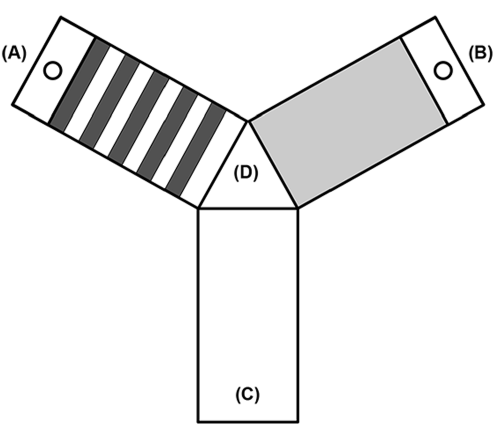
Figure 1. Y-mazes used to assess learning ability in L.delicata and L.guichenoti . Each maze had three arms of equal length. Two maze arms were painted with contrasting colours (orange and blue) and patterns (stripes and solids) to provide visual cues. All colour- pattern combinations were replicated and reversed in our study (four mazes total). Two arms contained feeding wells (A and B) whereas the third arm was empty and designated as the starting position for each trial (C). There was also a central decision point (D) we used to determine turning errors.